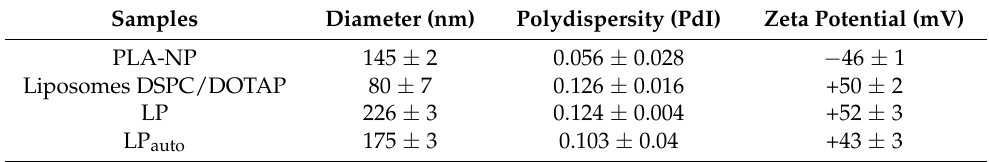
Figure 1. Preparation of LipoParticles ( A ) using the standard bulk method or ( B ) through an auto- mated mixing using microfluidic system. Table 1. Physicochemical characterization of PLA-NP, DSPC/DOTAP liposomes, LP, and LP auto through DLS and zetametry measurements. Results are presented as the mean ± SD of different samples ( n = 3).